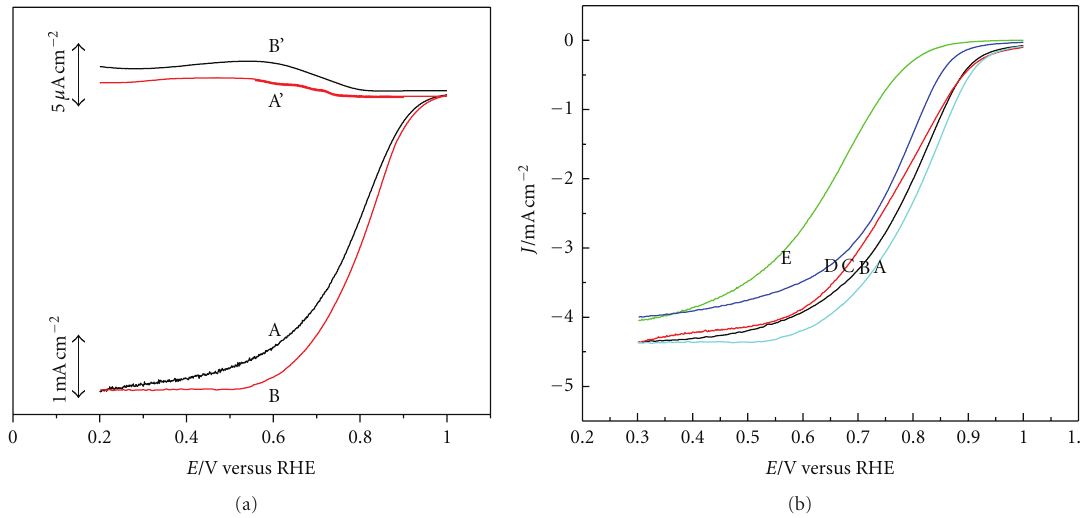
Figure 4: (a) Steady-state voltammograms for the ORR in O 2 -saturated HClO 4 (0.1M) solution, at GCE-supported (A) Pt nanoparticles and (B) Pt 53 -on-NiCo nanostructure surfaces. (b) Steady-state voltammograms for the ORR in O 2 -saturated HClO 4 (0.1 M) solution, at GCE- supported Pt x -on-NiCo nanostructures surfaces with di ff erent Pt contents: (A) 53%, (B) 71%, (C) 23%, (D) 12%, and (E) 5%. Rotation rate: 200 rpm; potential was scanned at the disk electrode from 1.0V to 0.0 V with scan rate of 10 mVs − 1 . Curves A’ and B’ represent the corresponding Pt ring currents (polarized at 0.7 V).